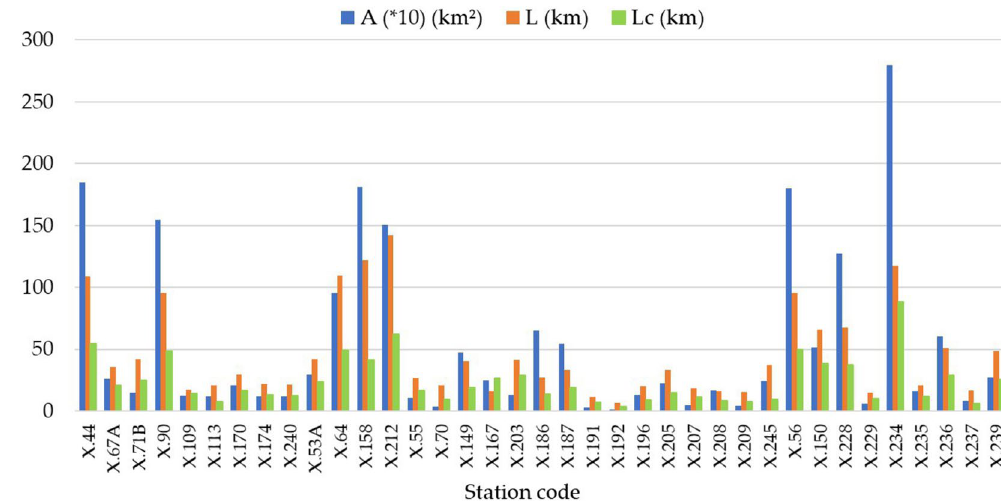
Figure 4. Physical characteristics information of the 37 runoff gauged